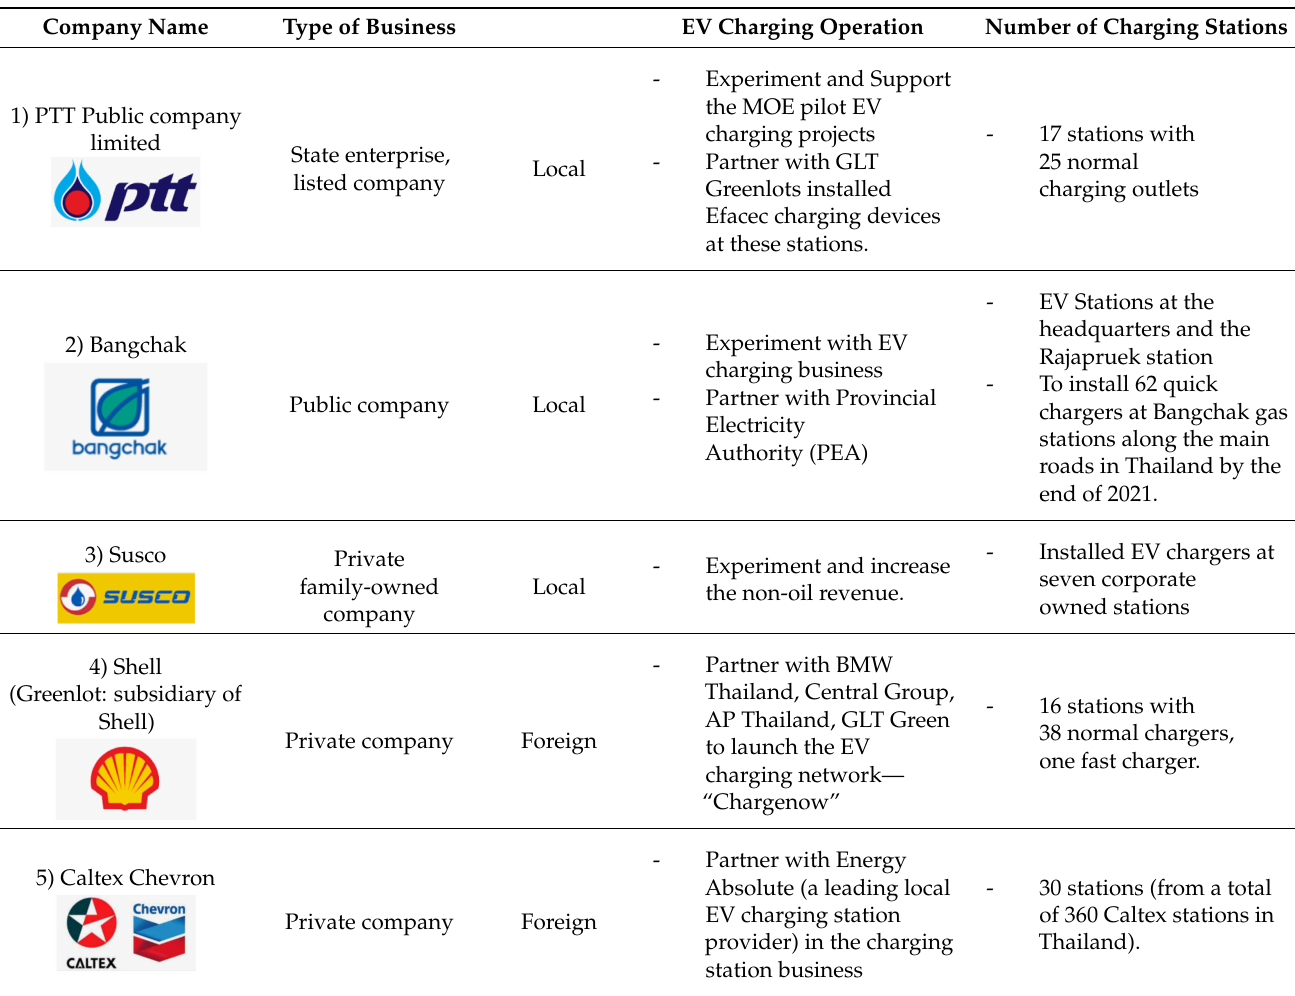
Table 4. EV charging operations of oil and gas